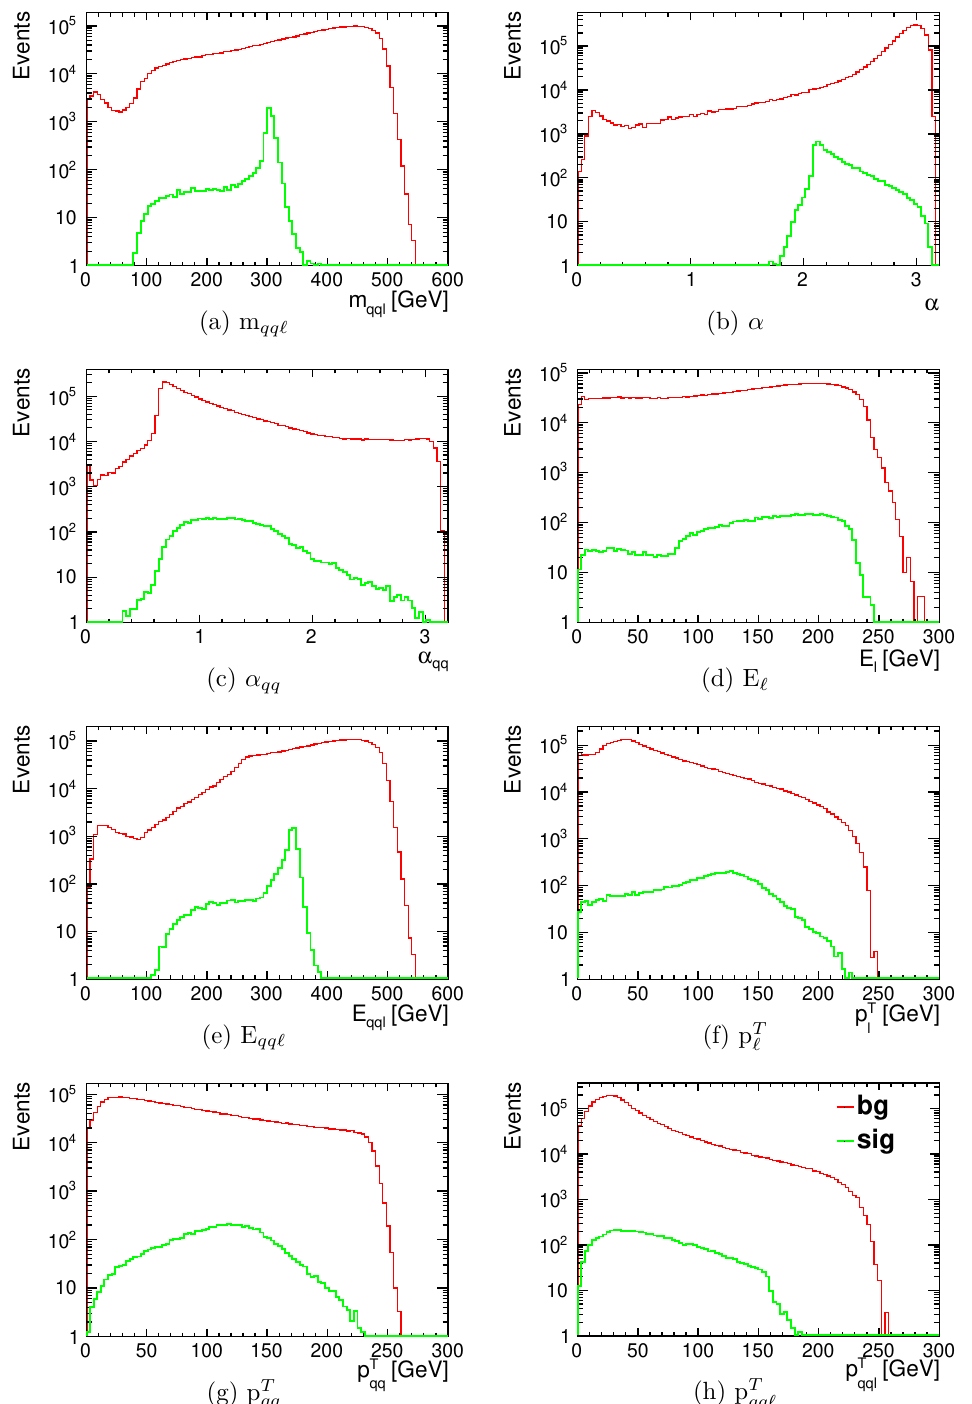
Figure 7. Distributions of the variables used in the BDT procedure for the reference scenario (Dirac neutrino, m = 300 GeV) with muons at ILC500. The red line stands for the background, N the green line for the